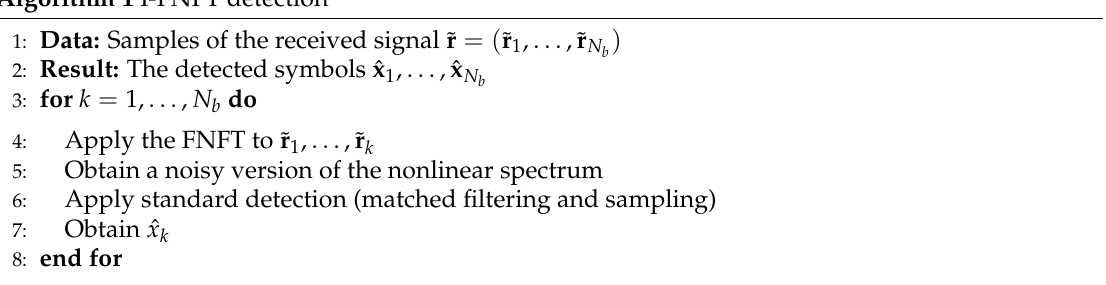
Algorithm 1 I-FNFT